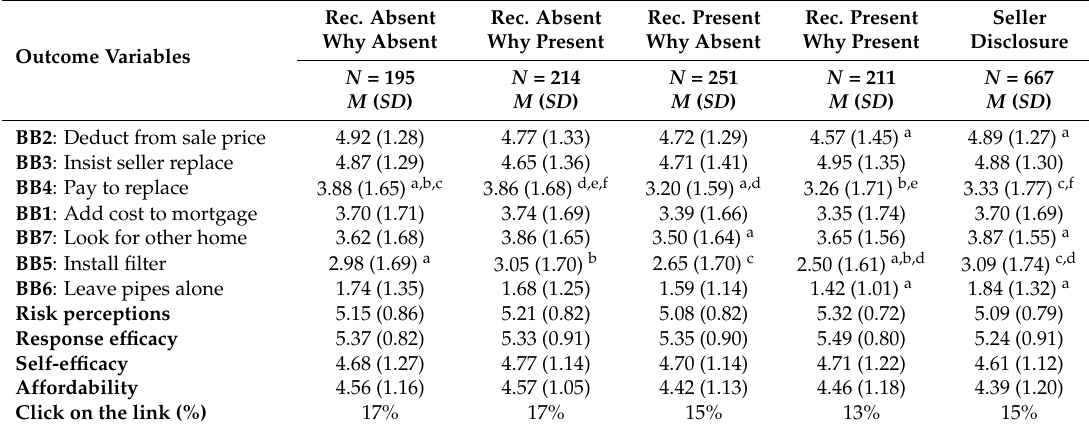
Table 5. Mean differences between disclosure conditions in the inspector/buyer study, and the aggregate results from the seller/buyer study (willingness items sorted by means).